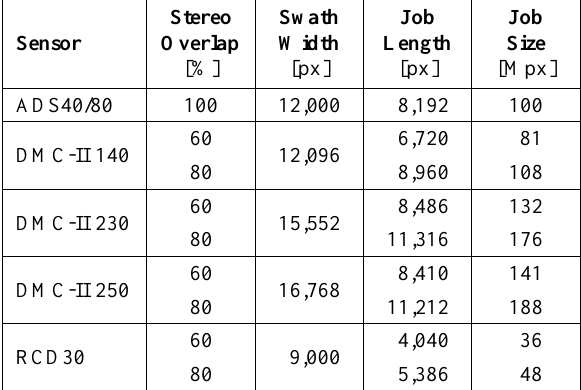
Table 1. SGM job properties for selected line scanner and frame sensors, based on Sandau et al. (2000) and Z/I Imaging